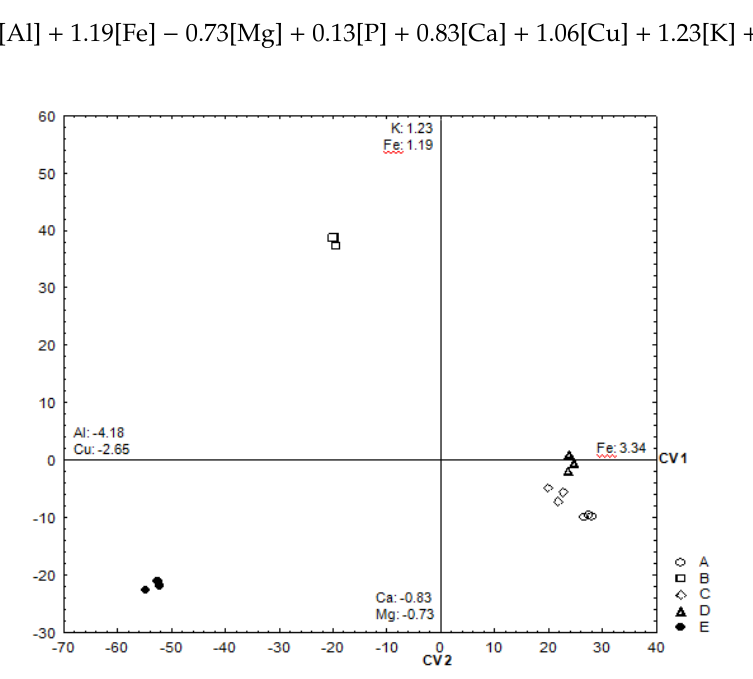
Figure 1. Scatterplot of all analyzed cases on the first canonical variate (CV1) versus the second canonical variate (CV2) (A: Diplopterys pubipetala ; B: Barnebya harleyi ; C: Croton adamantinus ; D: Hippocratea volubilis ; E: Couroupita guianensis )